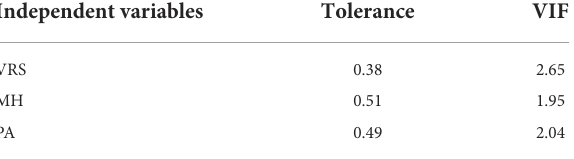
TABLE 7 Multicollinearity.